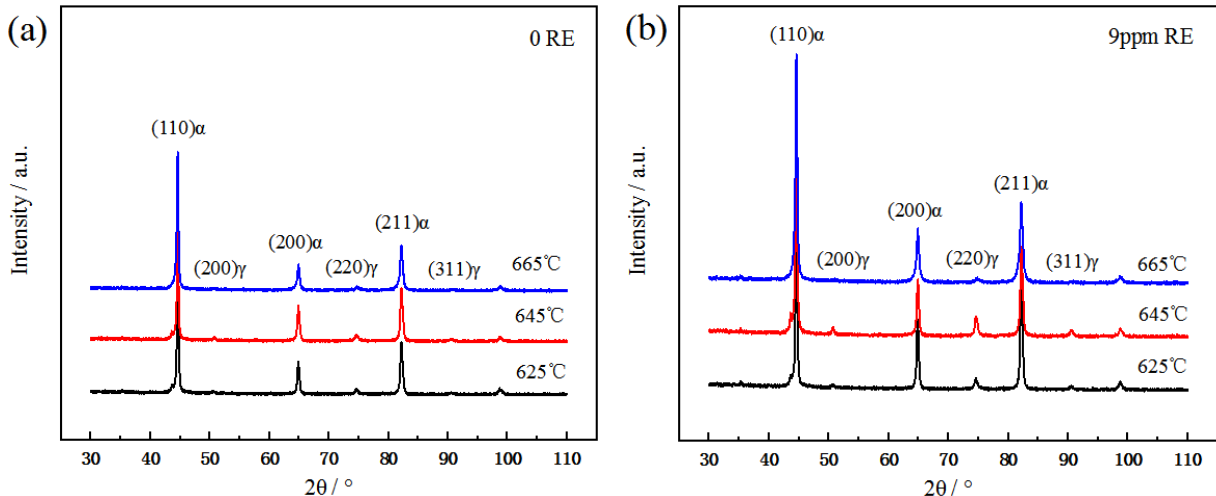
Figure 4. XRD patterns of the experimental steel at different annealing temperatures: ( a ) 0 RE, ( b ) 9 ppm RE.